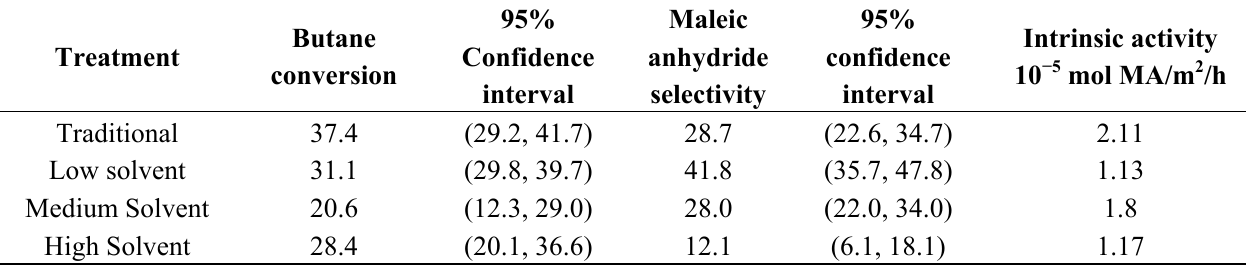
Table 3. Conversion, Selectivity and Intrinsic activities of traditionally and sol-gel prepared catalysts.